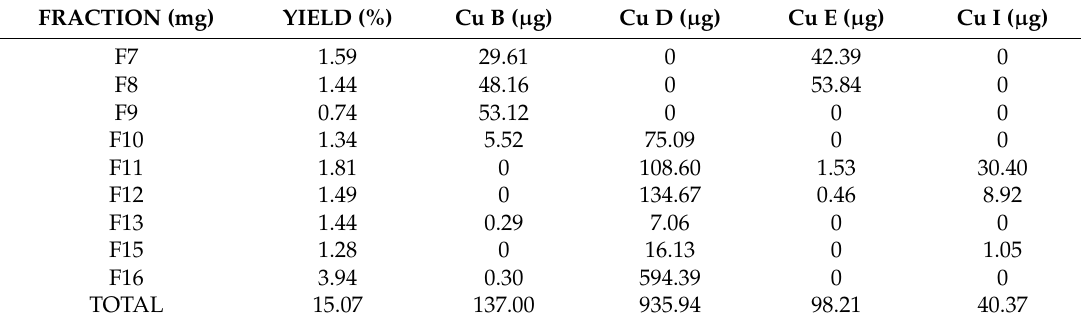
Table 1. Cucurbitacin yield ( µ g · mg − 1 ) of nine fractions of the methanolic extract from the fruits of the Sechium edule Perla Negra cultivar that had biological activity against the HeLa cancer cell